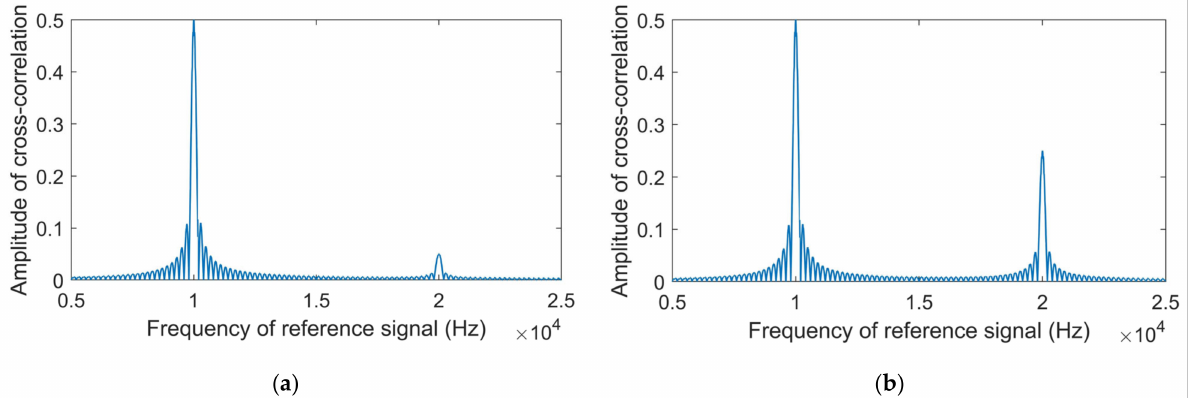
Figure 3. Cross-correlation spectrum of a harmonic with the amplitude ( a ) 0.1, and ( b )